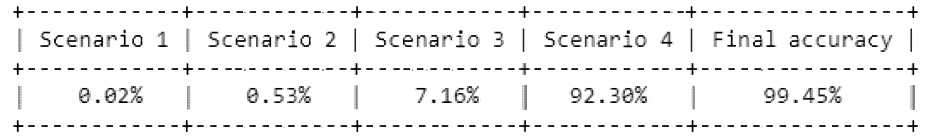
Figure 16. Temperature and blood pressure prediction algorithm.